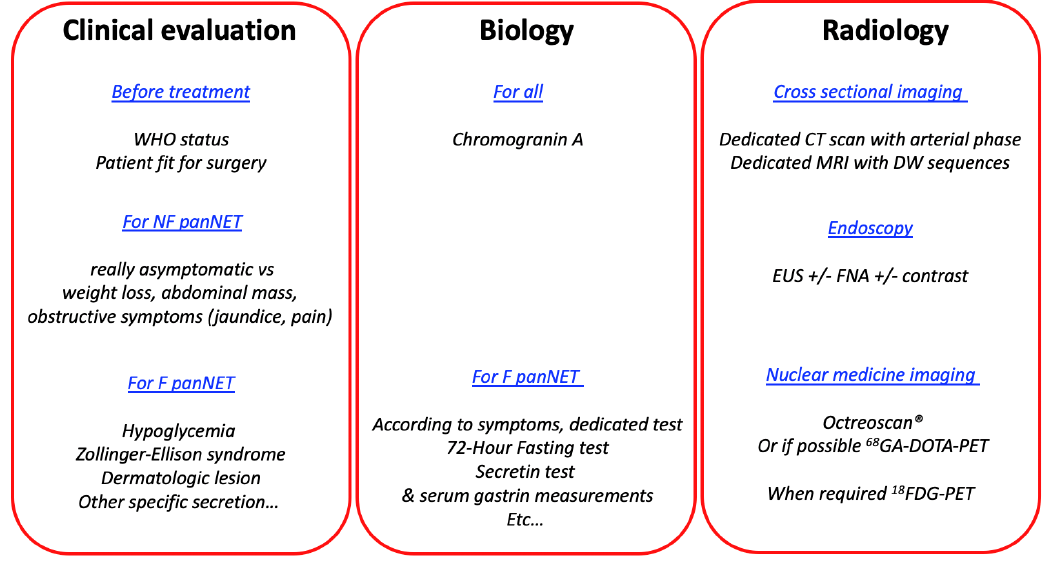
Figure 2. “Diagnose”, “locate“, “stage” and ‘grade” as accurately as possible the tumor.